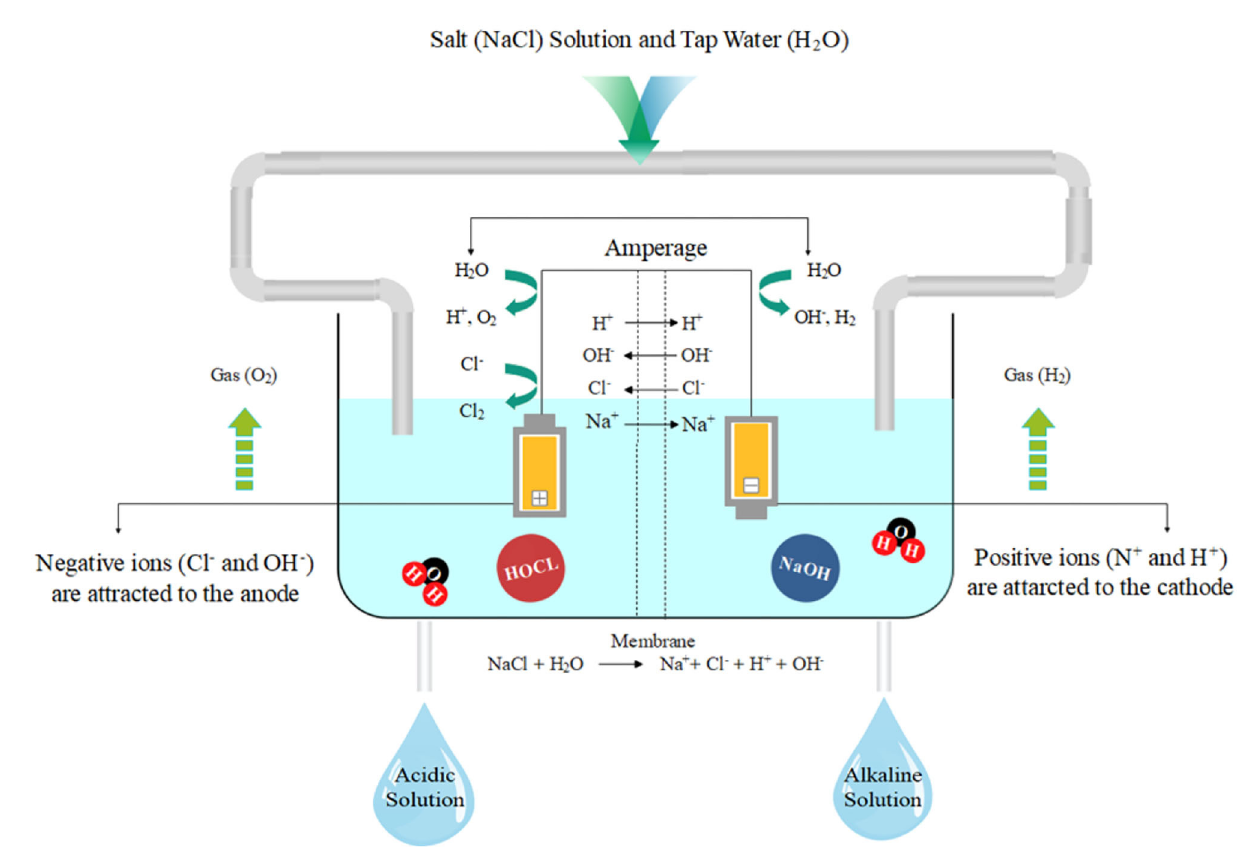
FIGURE2 Schematics of electrolyzed water production representing acidic electrolyzed water and alkaline electrolyzed